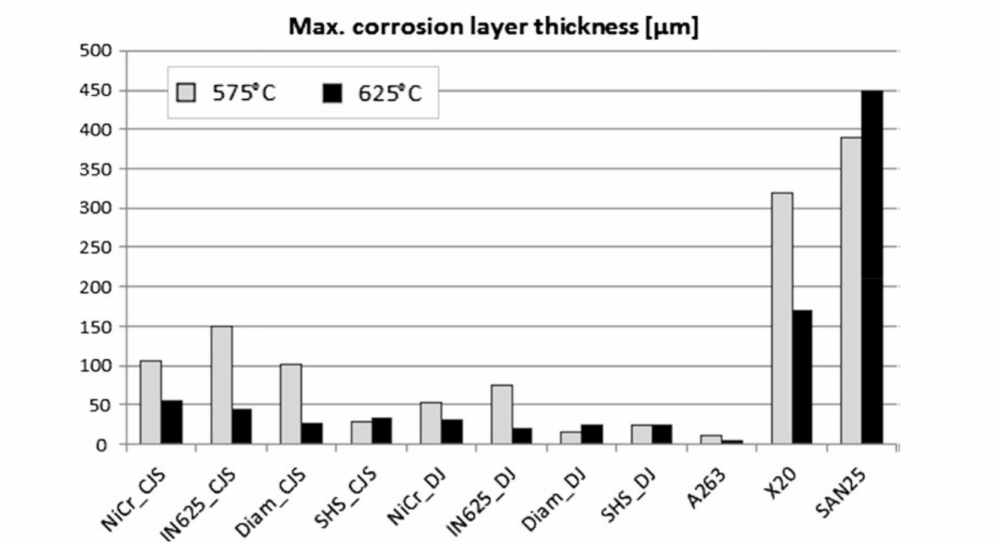
Figure 7. Maximum thickness values of the oxide / corrosion layers formed during the tests ( µ m)